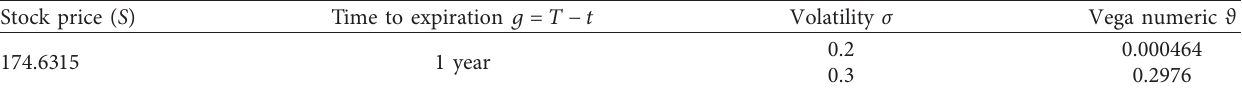
Figure 20: We plot exact and numerical values of vega at t � 0. (a) is for the Chebyshev method, and (b) is for the DQM. Table 6: Vega values for different volatilities.